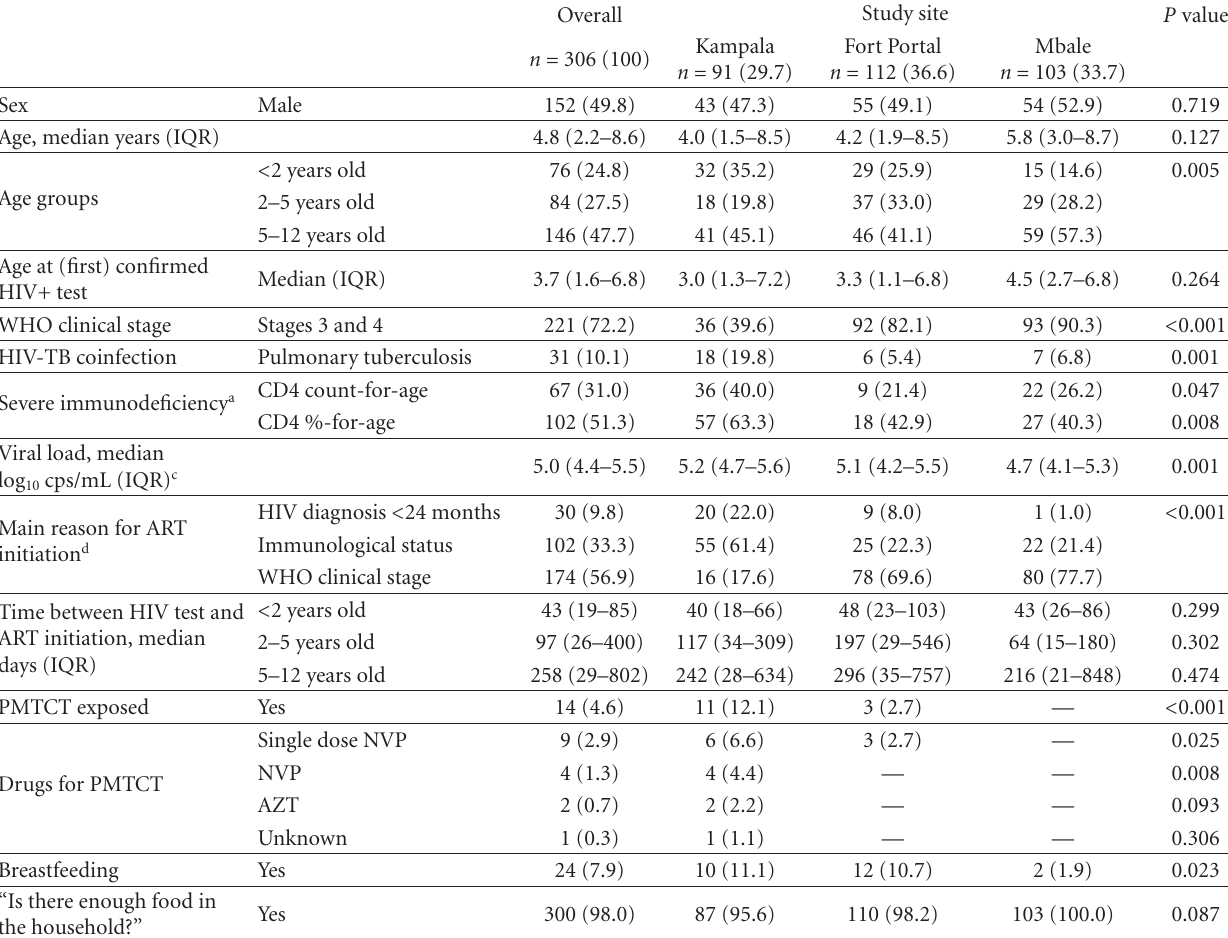
Table 2: Clinical and demographic characteristics of the “Monitoring of Antiretroviral Therapy in Children” cohort